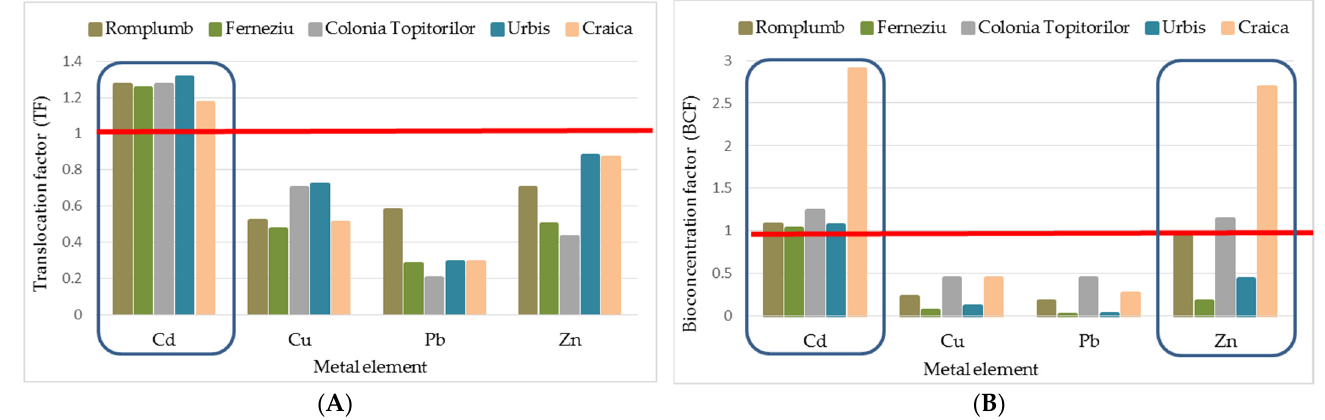
Figure 4. Correlation between the type of HM, experimental site and TF ( A ), and BCF ( B ). The red line marks the reference value (equal to 1) for the interpretation of TF and BCF.